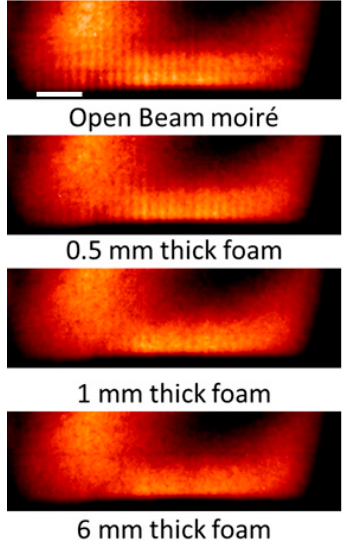
Figure 5. WOOFF images showing the open beam moir ė pattern, the reduction in fringe visibility for three thicknesses of insulation, 0.5 mm, 1 mm and 6 mm. The white scale bar in the open beam image is 7 mm.